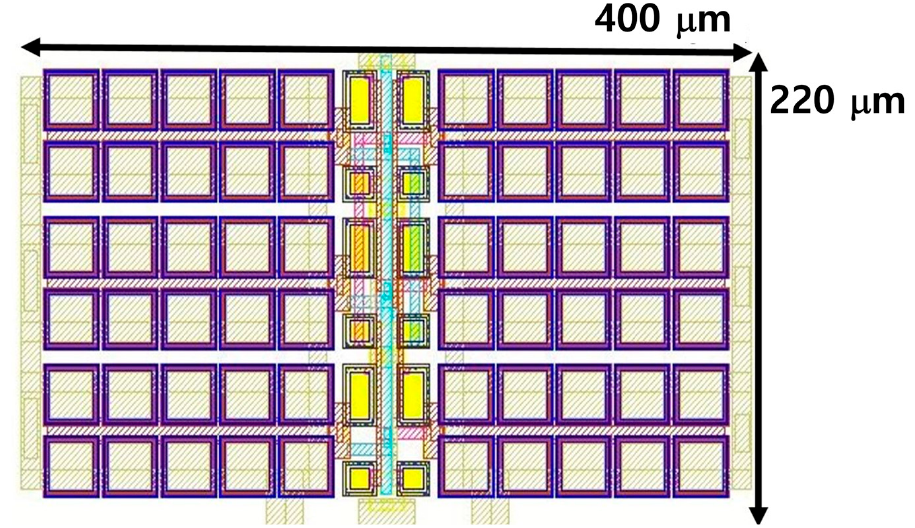
Figure 5. Layout of the proposed three-stage charge pump-based boost converter.